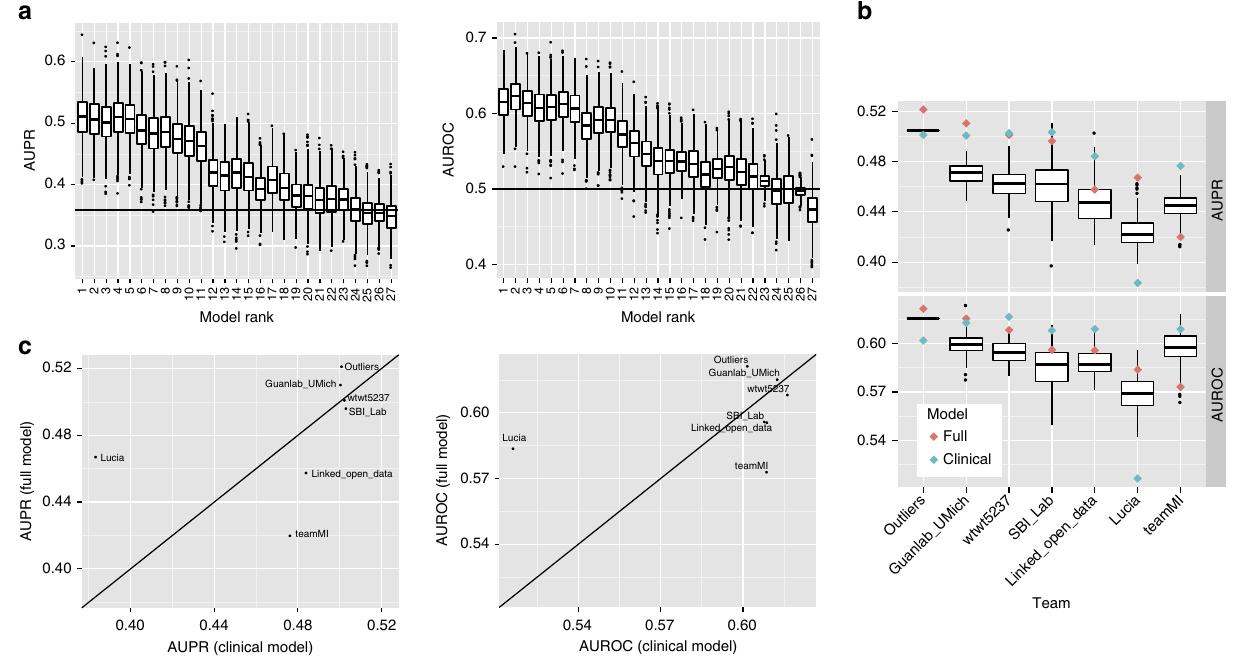
Figure 2 | Model performance. Competitive Phase: ( a ) Bootstrap distributions for each of the 27 models submitted to the classification subchallenge ordered by overall rank. The top 11 models were significantly better than random at Bonferroni-corrected P value o 0.05. Collaborative Phase: ( b ) Distributions of the models built with randomly sampled SNPs, by team, along with scores for their full model, containing data-driven SNP, as well as clinical variable selection, (pink) and clinical model, which contains clinical variables but excludes SNP data (blue). For 5 of 7 teams, the full models are nominally significantly better relative to the random SNP models for AUPR, AUROC or both (enrichment P value 4.2e (cid:2) 5). ( c ) AUPR and AUROC of each collaborative phase team’s full model, containing SNP and clinical predictors, versus their clinical model, which does not consider SNP predictors. There was no significant difference in either metric between models developed in the presence or absence of genetic information (paired t -test P value ¼ 0.85, 0.82, for AUPR and AUROC,